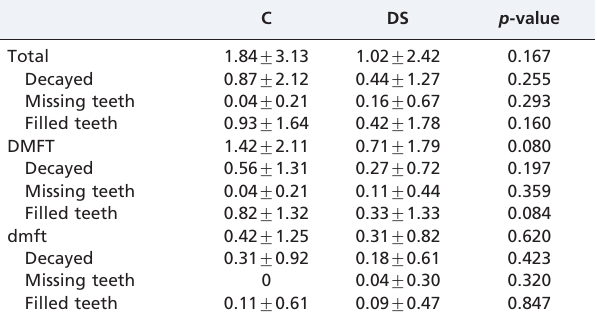
Table 2 - The total numbers of decayed, missing and filled primary (dmft) and permanent (DMFT) teeth in Down syndrome (DS) children and sibling controls